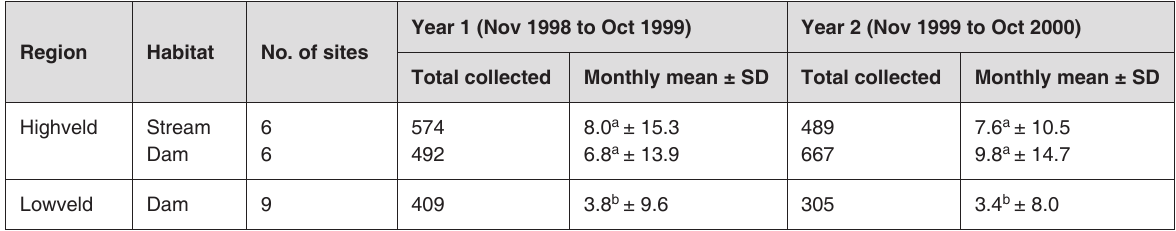
TABLE 5 Recovery of Bulinus globosus according to habitat from seven districts in the highveld and lowveld communal grazing areas of Zimbabwe for the period November 1998 to October 2000